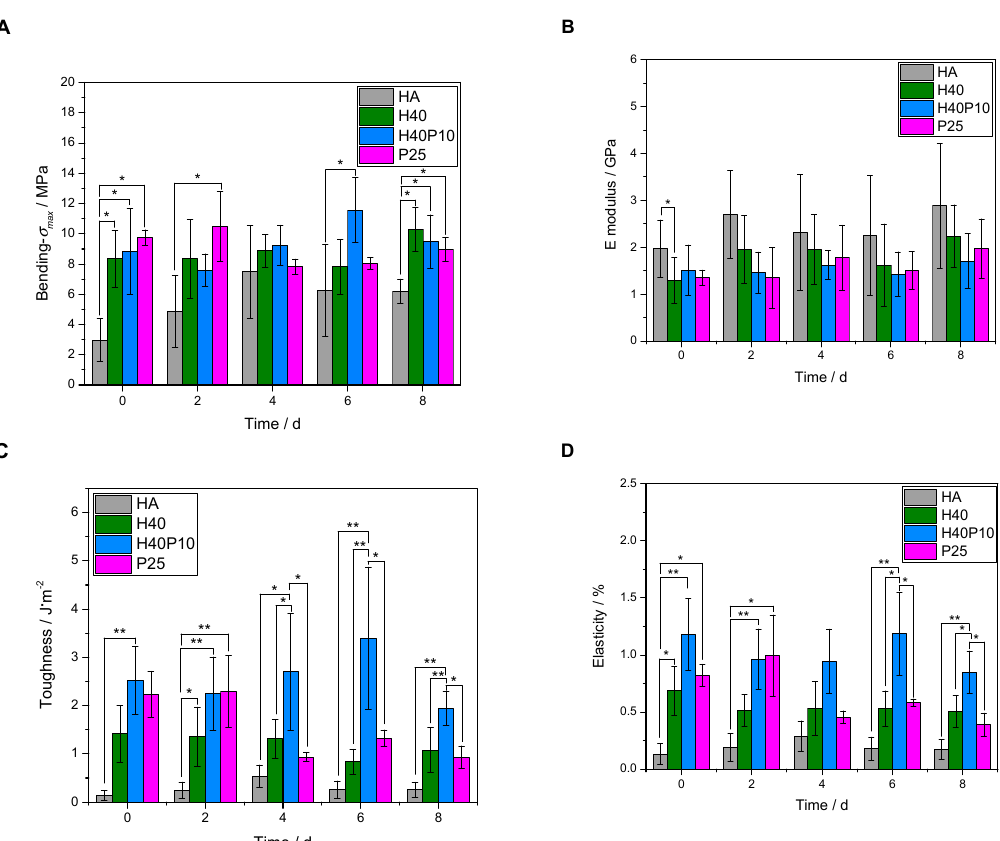
Figure 10. Overview of different parameters calculated out of four-point bending test. First, maximum bending strength of all batches over a period of eight days was determined ( A ). Furthermore, a calculation of relevant measures for evaluating influence of polymeric additions was performed: E-modulus ( B ), toughness ( C ), and elasticity ( D ) of the system. * p < 0.05; ** p <